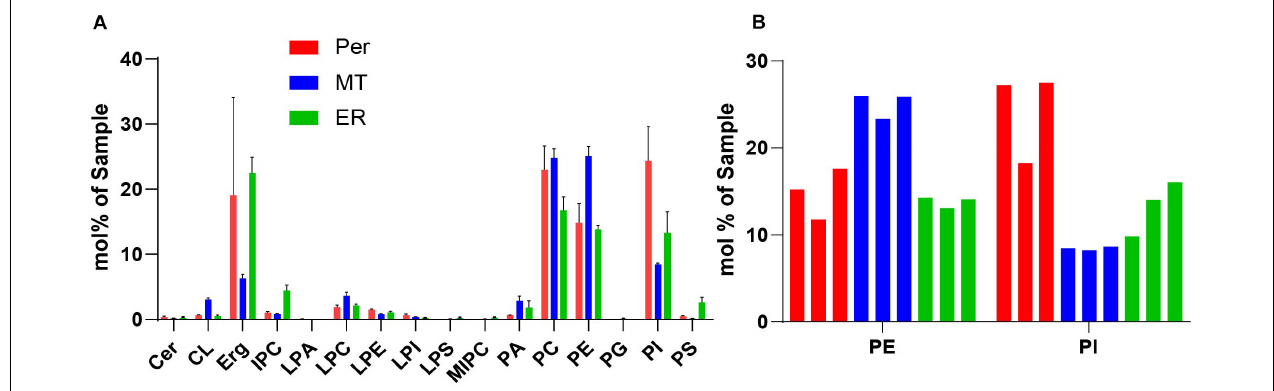
FIGURE 5 | (A) Selected lipidomics data of isolated organelles. Peroxisomes (red, Per), mitochondria (blue, MT), and ER (green), indicating generally high levels of phospholipids (PC, PE, and PI), and in comparison, increased levels of PI for peroxisomes. Shown are mean values with standard deviation from three indipendent experiments. For more detailed lipidomics data see Supplementary Figure 1 . (B) Lipidomic data of PE and PI in Peroxisomes, Mitochondra and ER were from three independent experiments. Mole percentages of the total amount of lipids are shown on the y -axis (sum amount of a lipid class divided by the total amount in the sample, multiplied by 100).